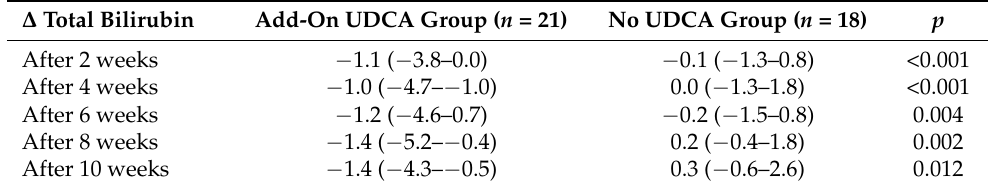
Figure 2. Comparison of the amount of total bilirubin (TB) changes between groups with and with- out add-on ursodeoxycholic acid (UDCA). The amount of TB depletion was significantly larger in the add-on UDCA group than in the no UDCA group. 4. Discussion This retrospective cohort study was conducted to establish how best to deal with GP- induced liver injury, which occasionally becomes serious and can lead to therapy 0